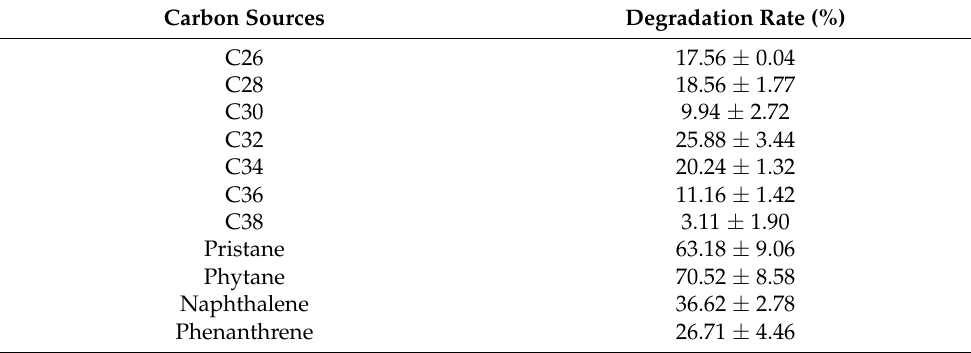
Table 3. Bacterial degradation efficiency of various carbon